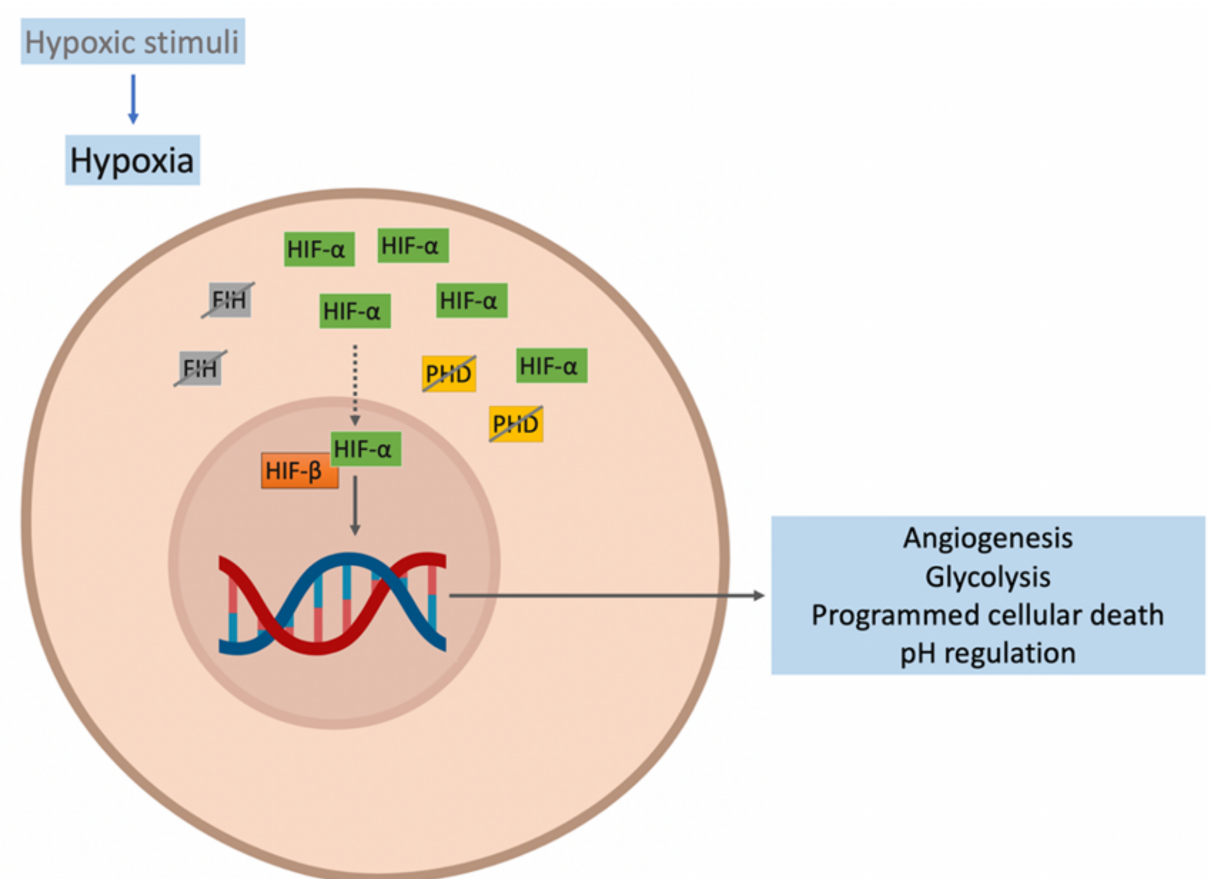
Figure 1. Response to hypoxia. The activity of the prolyl hydroxylase domain (PHD) and factor- inhibiting hypoxia (FIH) are reduced, favoring hypoxia-inducible factor (HIF)- α accumulation and its translocation to the nucleus. In the cell nucleus, the HIF- α /HIF- β heterodimer is formed. This forms a complex that binds to the hypoxia response elements (HRE) of HIF target genes and activates the expression of more than 200 genes, initiating the activation of cellular pathways to enhance the oxygen in the